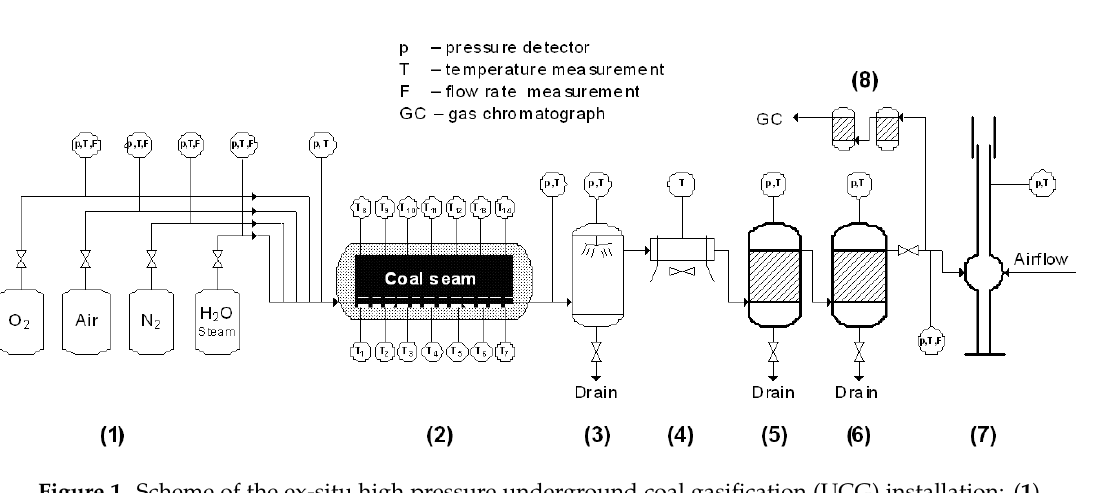
Figure 1. Scheme of the ex-situ high pressure underground coal gasification (UCG) installation: ( 1 ) gasification reagents, ( 2 ) gasification reactor ( 3 ) water scrubber, ( 4 ) air cooler, ( 5 , 6 ) separators, ( 7 ) thermal combustor, ( 8 ) gas treatment module prior to gas chromatography (GC) analysis [30]. Reproduced from [30], Elsevier: